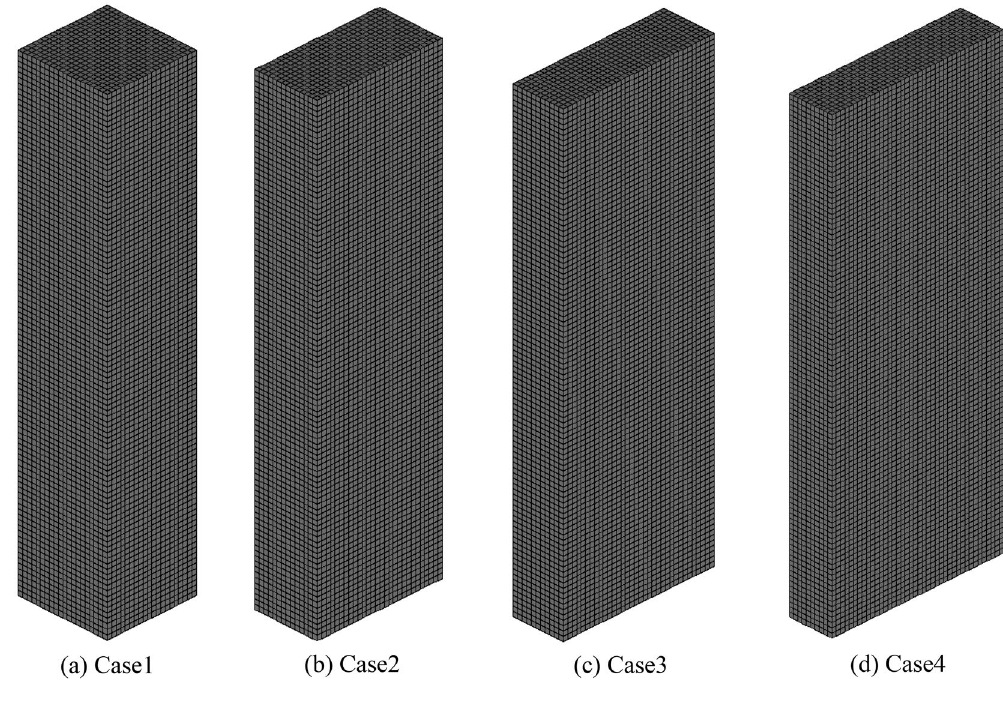
Figure 1. Computational domain and grids.